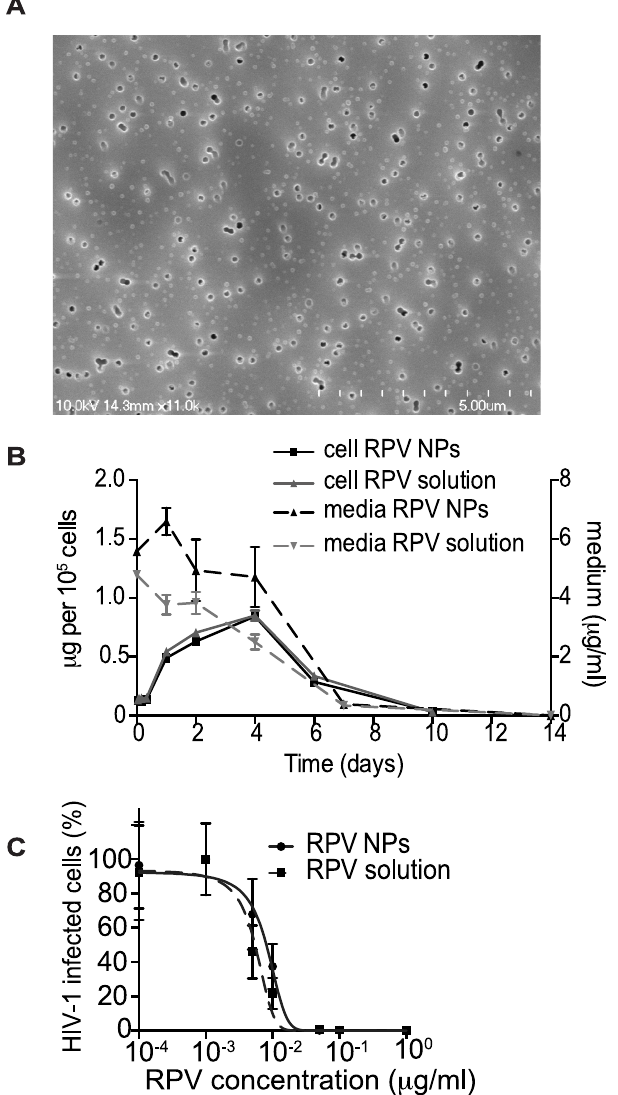
Fig 2. In vitro characterization of PLGA/RPV NPs in thermosensitive gel. (A) Scanning electron microscope image of PLGA/RPV nanoparticles. (B) RPV uptake by HeLa cells. Cells were incubated with 5 μ g/ml RPV in solution or in the PLGA/RPV NP formulation. Intracellular RPV and RPV in medium were analyzed by HPLC (n = 3). (C) In vitro analysis of the inhibition of HIV infection by PLGA/ RPV NPs. TZM-bl HIV indicator cells were treated with the indicated concentrations of RPV solution or PLGA/RPV NPs. Cells were challenged with HIV-1 NLX 24 h after RPV treatment. Infection of cells was evaluated by ONE-Glo assay 48 h post infection (n = 3). Data were normalized to luminescence of untreated cells (100%); p =